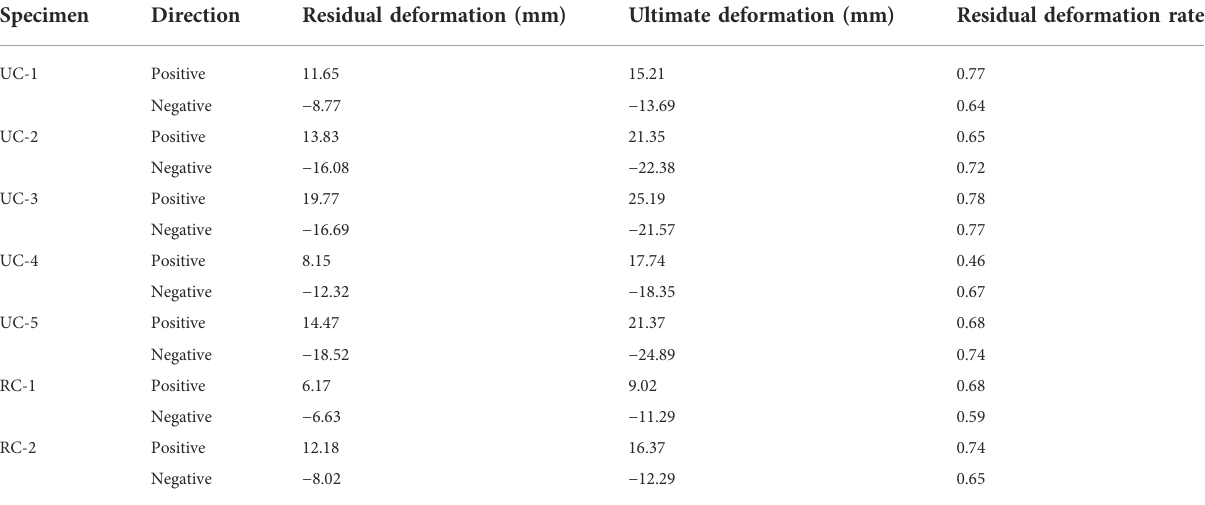
TABLE 7 Deformation recovery index of test